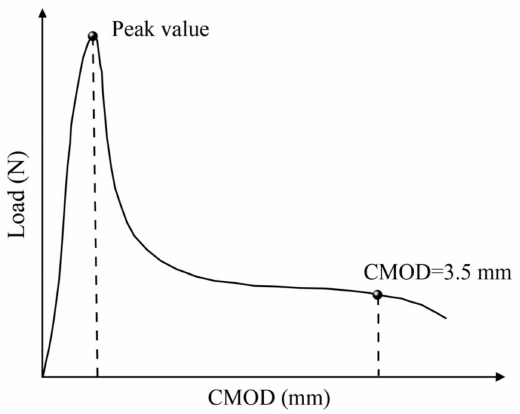
Figure 3. Load–CMOD schematic curve.